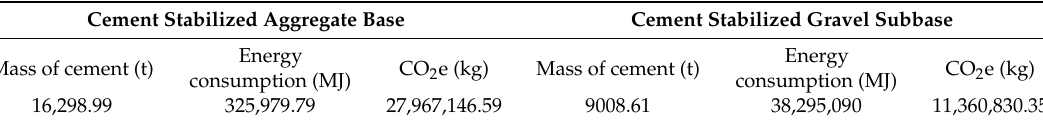
Table 4. GHG emissions of cement stabilized